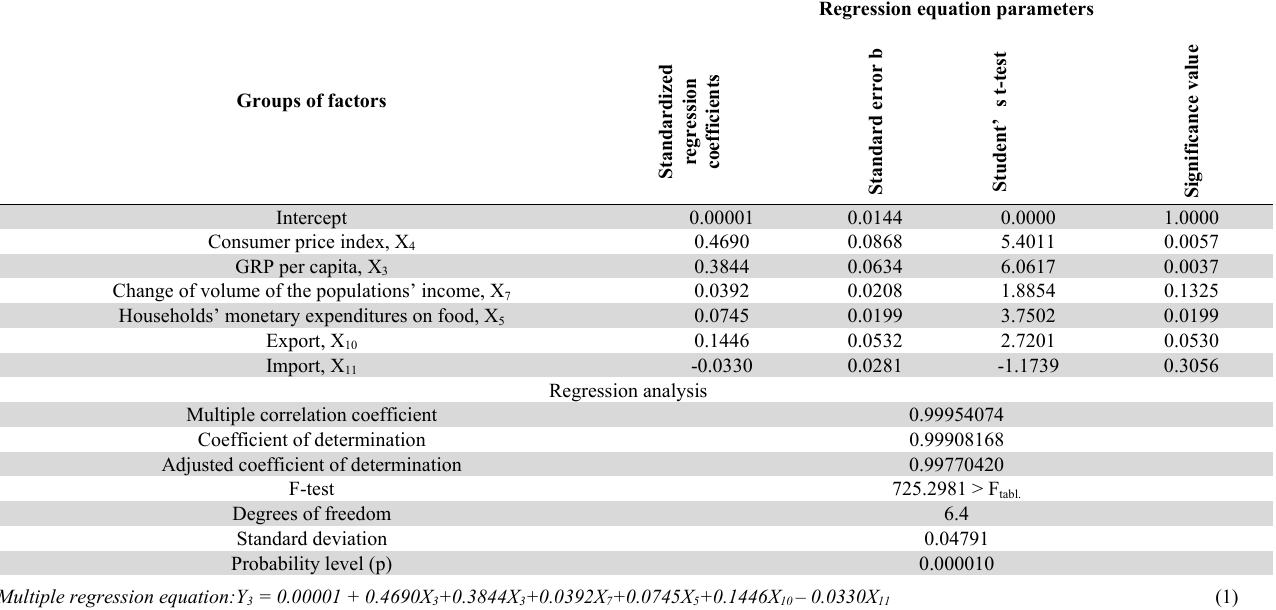
Table 2 Results of the regression analysis of the consumer capacity of the regional food market in Lvivska oblast and socio-economic factors